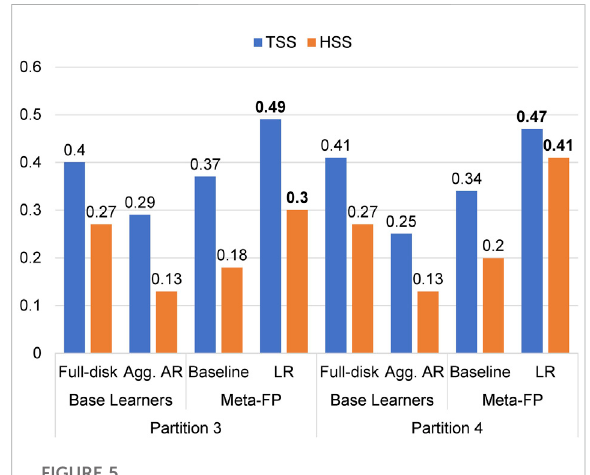
FIGURE 5 Validation Scores of base learners in Fold-1 (base